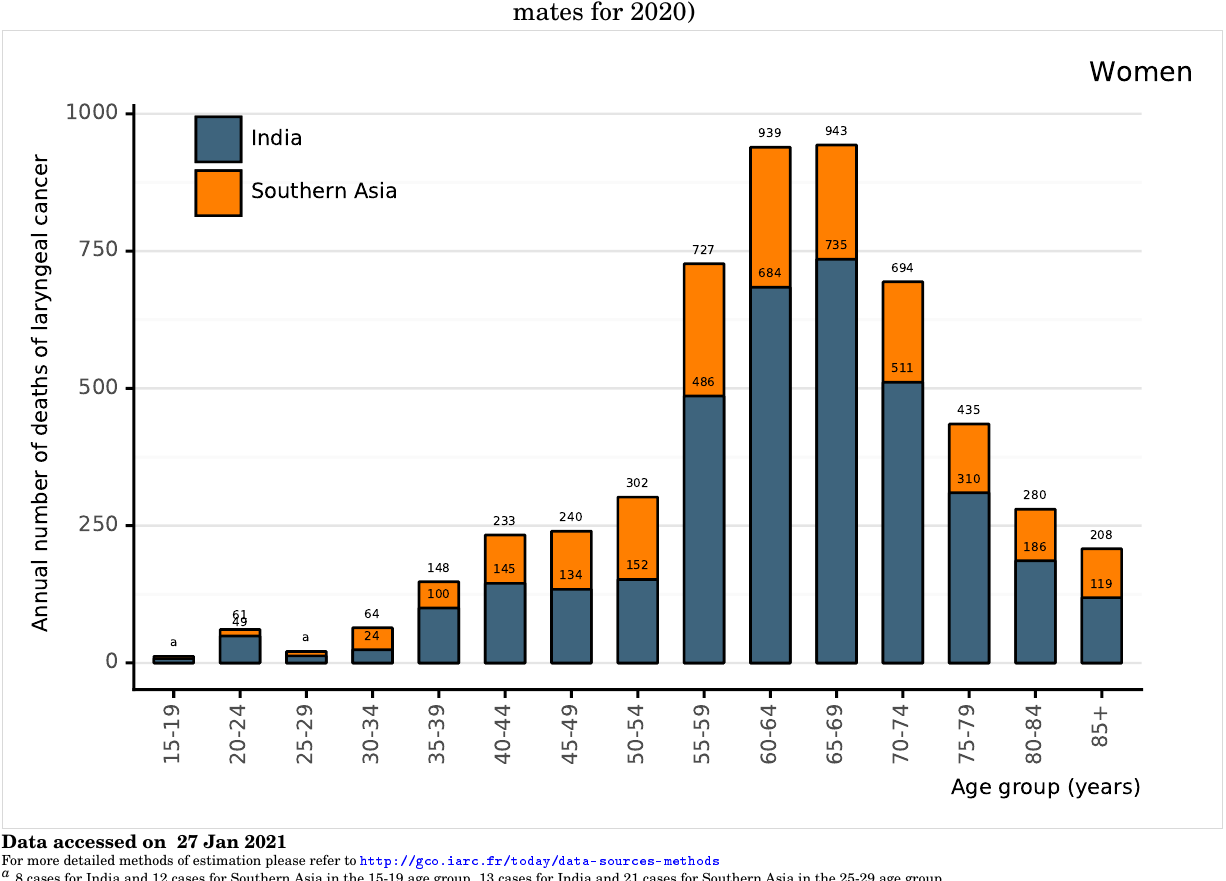
Figure 134: Annual number of deaths of laryngeal cancer among women by age group in India